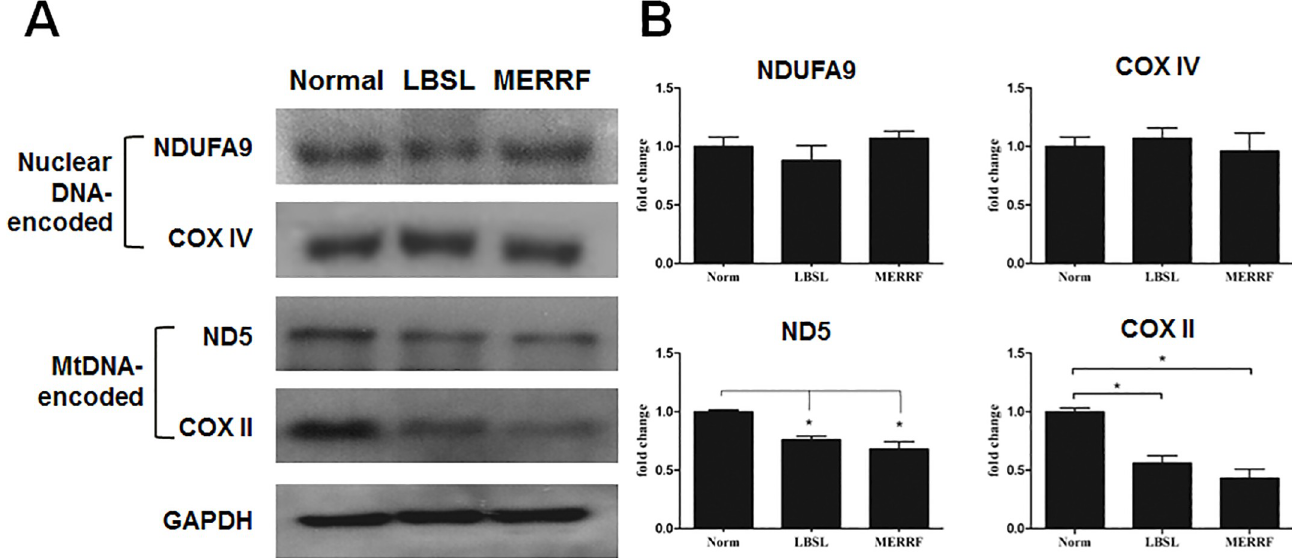
Fig 2. DARS2 defect leads to reduced mitochondrial translation. (A) Representative image of immunoblotting. Nuclear and mitochondria DNA-encoded proteins of mitochondrial respiratory complexes in fibroblasts derived from normal human, LBSL and MERRF patient were used for assay. (B) Quantitative histogram of protein expression. � p < 0.05 between indicated